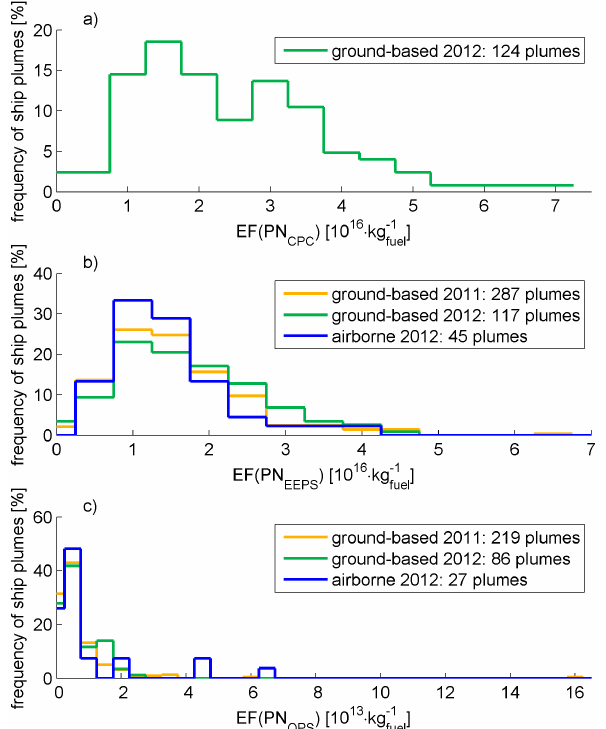
Figure 8. Frequency distribution of emission factors for particle number shown for (a) CPC (>5µm), (b) EEPS (5.6 to 560nm) and (c) OPS (0.3 to 10µm).